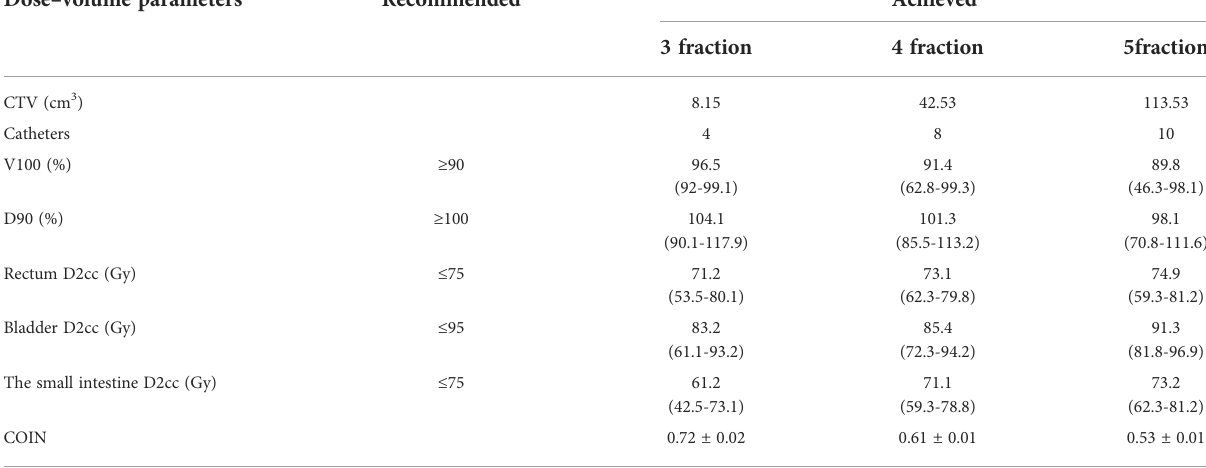
TABLE 2 Recommended and achieved dose – volume parameters for ISBT. Dose – volume